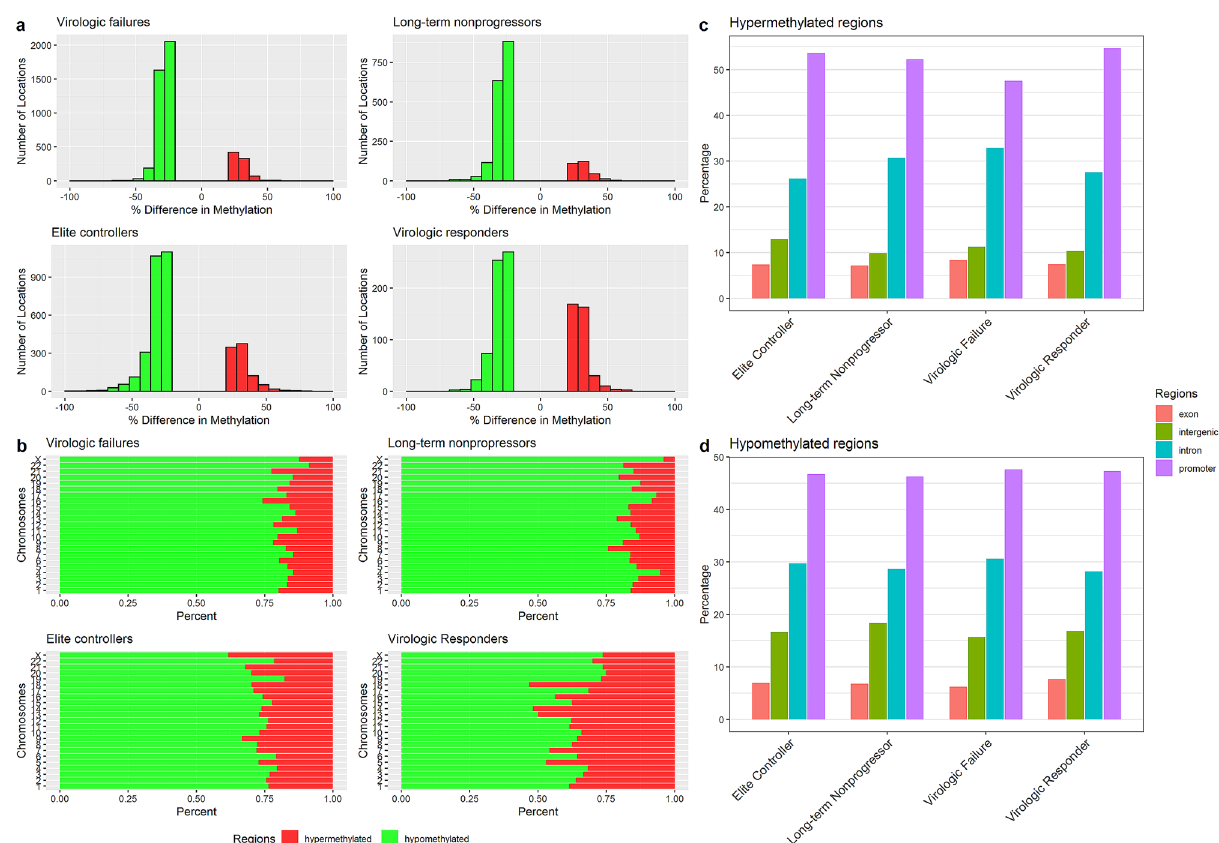
Figure 2. Differential methylation analysis. Methylation percentages were calculated for windows encompassing 100 bp. Then, methylation percentages for each region in HIV groups were compared against a control group. A cutoff of ≥ 25% for methylation difference and a q-value of < 0.01 were considered for the analysis. ( a ) Number of locations showing hyper and hypomethylation in HIV groups compared with controls. ( b ) Percent of hypo and hypermethylated regions across human chromosomes. ( c ) Annotation of differential methylation showing the percentage of differentially hypermethylated regions distributed across exons, intergenic, introns and promoter regions. ( d ) Annotation of differential methylation showing the percentage of differentially hypomethylated regions distributed across exons, intergenic, introns and promoter